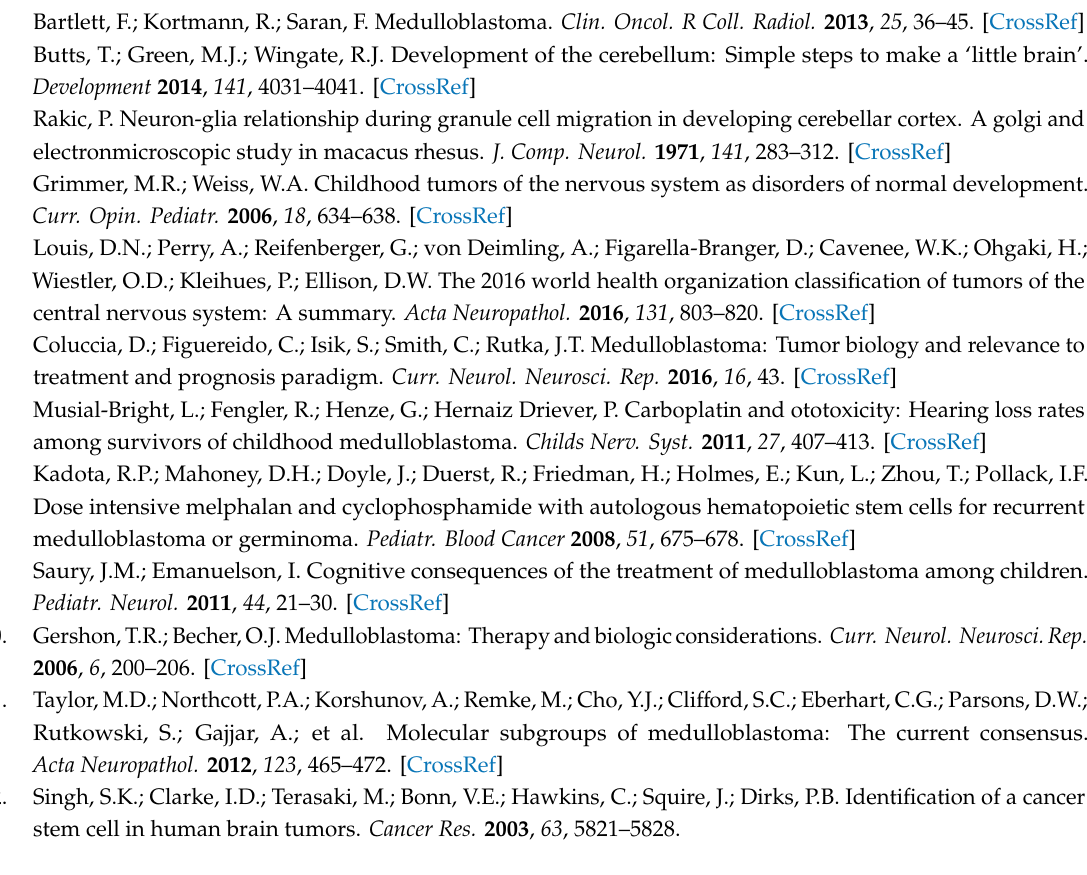
markers of Figure 2B, Figure S9: The uncropped blots and molecular weight markers of Figure 2C, Figure S10: The uncropped blots and molecular weight markers of Figure 2D, Figure S11: The uncropped blots and molecular weight markers of Figure 4A, Table S1: Aldaregia List of